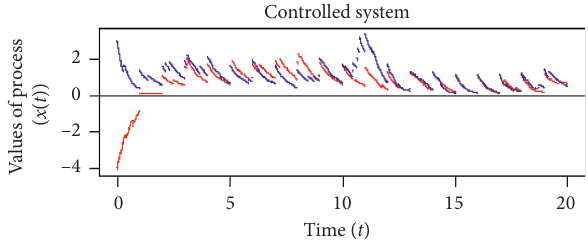
Figure 1: Two solutions of systems (35)–(37) with initial condi- tions − 4 and 3 and parameters from the model